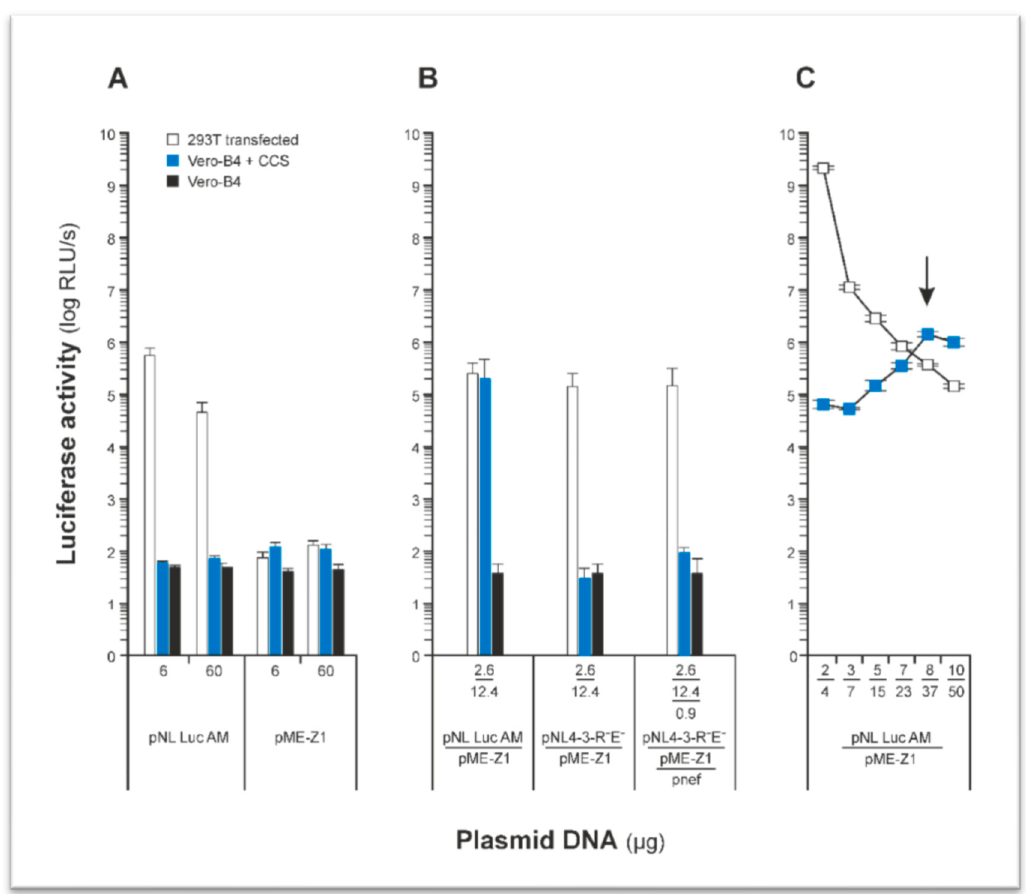
Figure 1. Luciferase activity in transfected HEK293T cells and Z1-HIV luc infected Vero-B4 cells transfected with di ff erent amounts of plasmids. ( A ) Transfection and infection controls. ( B ) Comparison of pseudotype production by viral vectors pNL Luc AM ( nef + ) and pNL4-3-R − E − , ( nef − ). pnef, plasmid for expression of the HIV-1 nef protein. pME-Z1, expression of pr ME. Transfections for the comparison were carried out in 24 wells, in contrast to experiments described in ( A ) and ( C ). Cell culture supernatants (CCSs) were tested at a 1:5 dilution for infection of Vero-B4 cells. Numbers indicate µ g of plasmid DNA used for transfection. ( C ) From HEK293T transfected cells, CCS was diluted 1:5 and used for infection of Vero-B4 cells. Plasmid ratios (in µ g) of pNL Luc AM and pME-Z1 were as follows: 6 = 2 + 4, 10 = 3 + 7, 20 = 5 + 15, 30 = 7 + 23, 45 = 8 + 37, and 60 = 10 + 50. pNL Luc AM: vector for HIV-1 core production ( env − , luc + , nef + ). pME-Z1: Zika pr ME envelope expression plasmid. Y-axis: relative light units (RLU) measured in HEK293T cells transfected with plasmids (white squares or bars) or ( A ) and ( B ) Vero-B4 cells CCS inoculated (blue bars) or ( C ) infected with Z1-HIV luc containing CCS (blue squares). Black bars: luciferase background activity in non-transfected and non-infected Vero-B4 cells. X-axis: µ g plasmid DNA used for transfection of HEK293T cells.